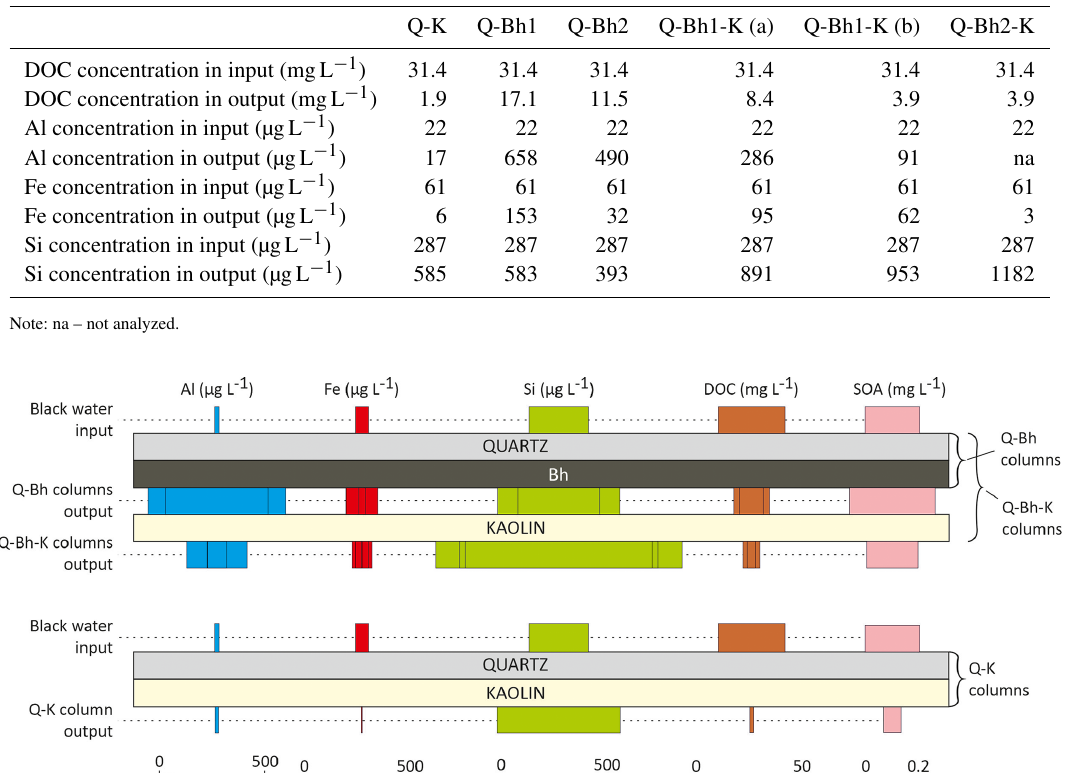
Table 3. C, Al, Fe and Si transferred in dissolved phase in the column experiments. Output values correspond to the composite samples. Analytical percent error: C – 1.4; Al – 6.0; Fe – 4.8; Si – 1.9.